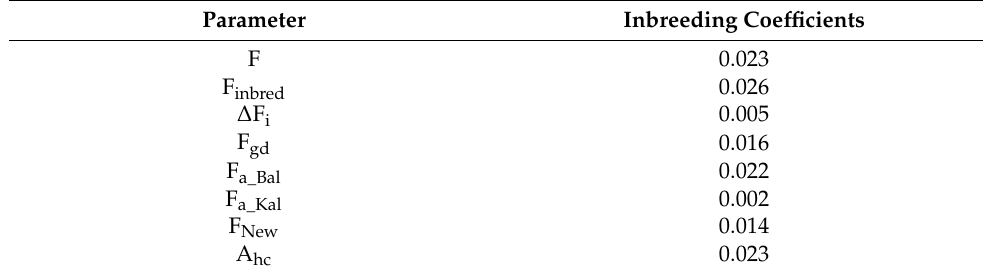
Table 3. Average inbreeding coefficient for all animals (F) and inbred animals (F inbred ), individual rate of inbreeding per generation ( ∆ F i ), individual inbreeding using the genedrop method (F gd ) and ancestral inbreeding according to Ballou (F a_Bal ) and Kalinowski (F a_Kal ), new inbreeding according to Kalinowski (F New ) and ancestral history coefficient according to Baumung (A hc ) for German Brown from the birth years 1990 to